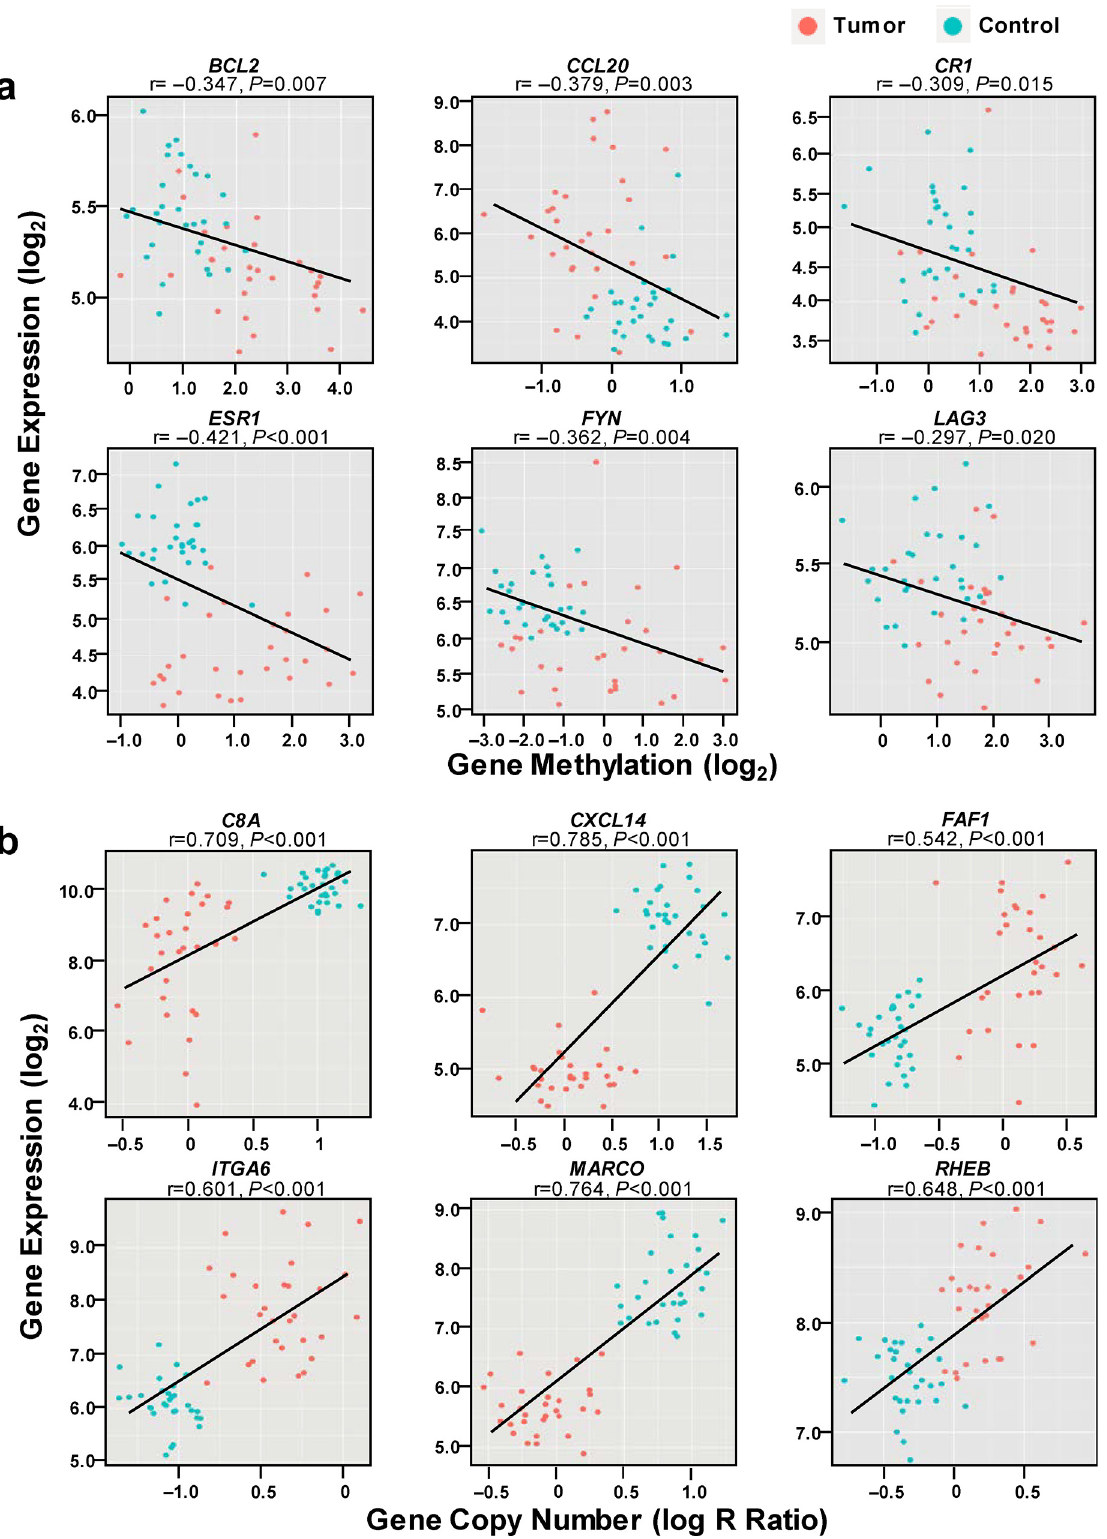
Fig 2. Relationship between mRNA expression and DNA methylation (a) or SCNA (b) of the randomly selected inflammation-related genes. Tumor, HCCs; Control, paired no-tumor tissues. doi:10.1371/journal.pone.0126836.g002 PLOS ONE | DOI:10.1371/journal.pone.0126836 May 12,